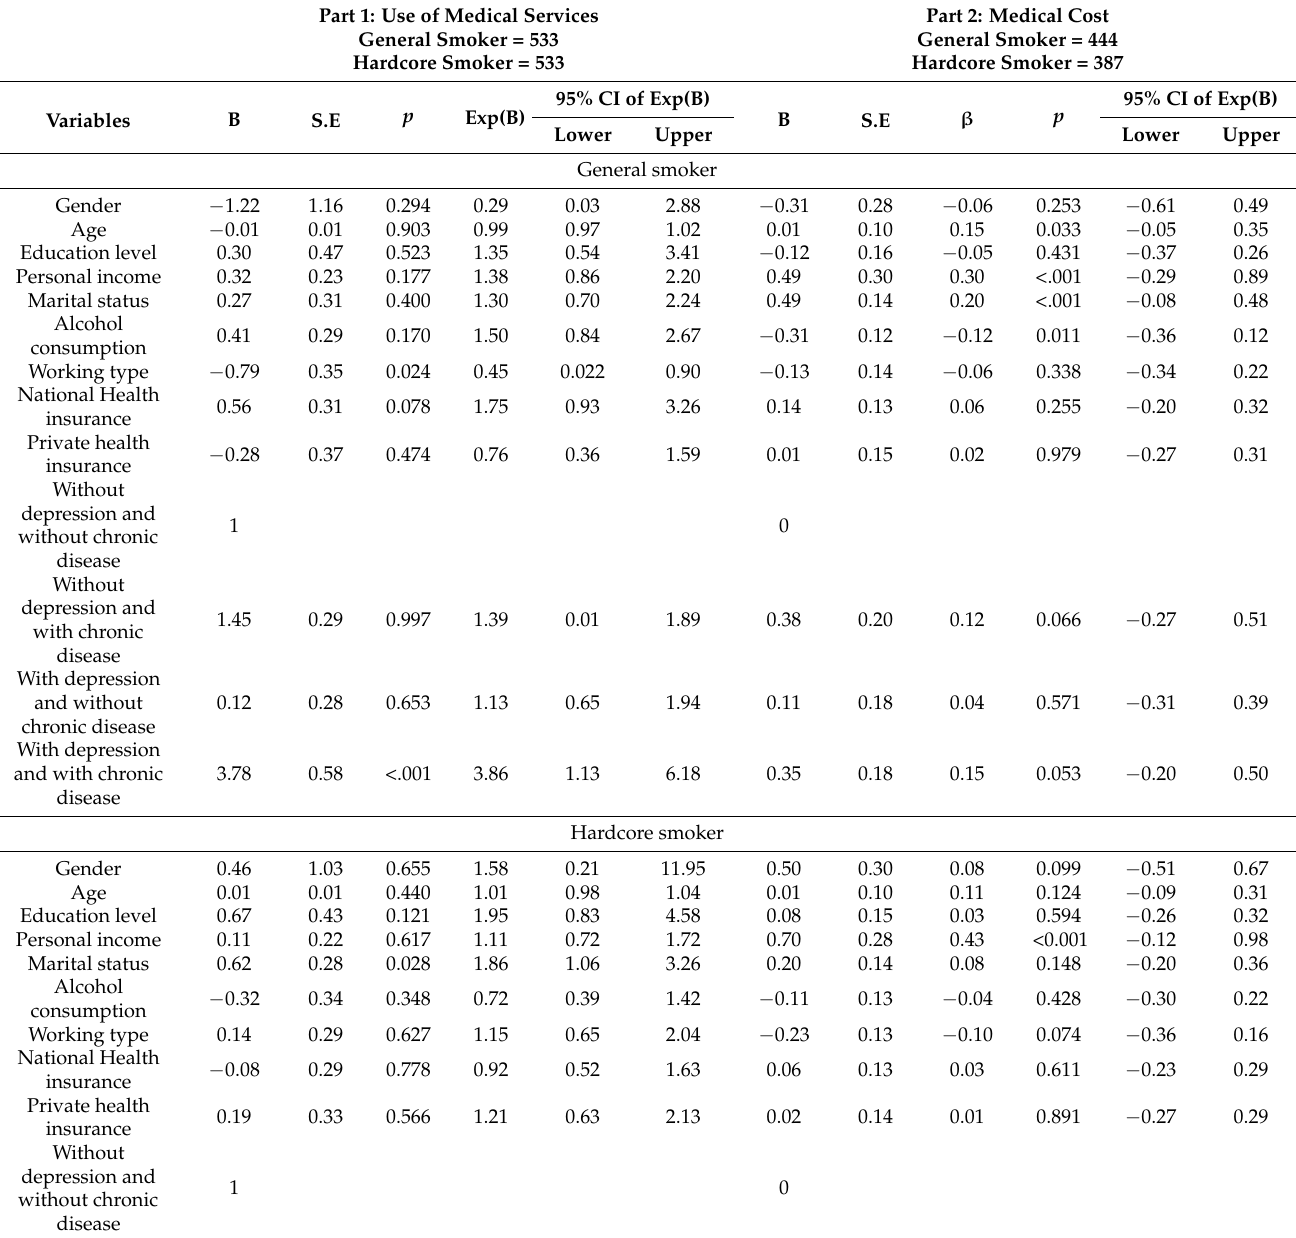
Table 5. Effect of subject’s depression and chronic disease on medical service use and medical